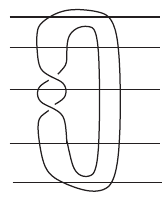
Figure 7: Basic elements and slicing of an Hopf